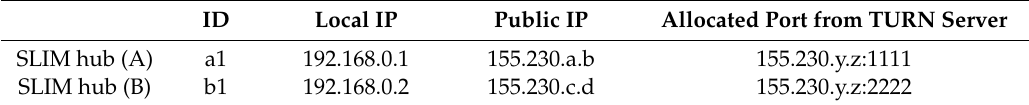
Figure 9. Register ID and local and public IPs, sent to the server. Table 1. A table that stores the state information of the slim hub on the coordination server.